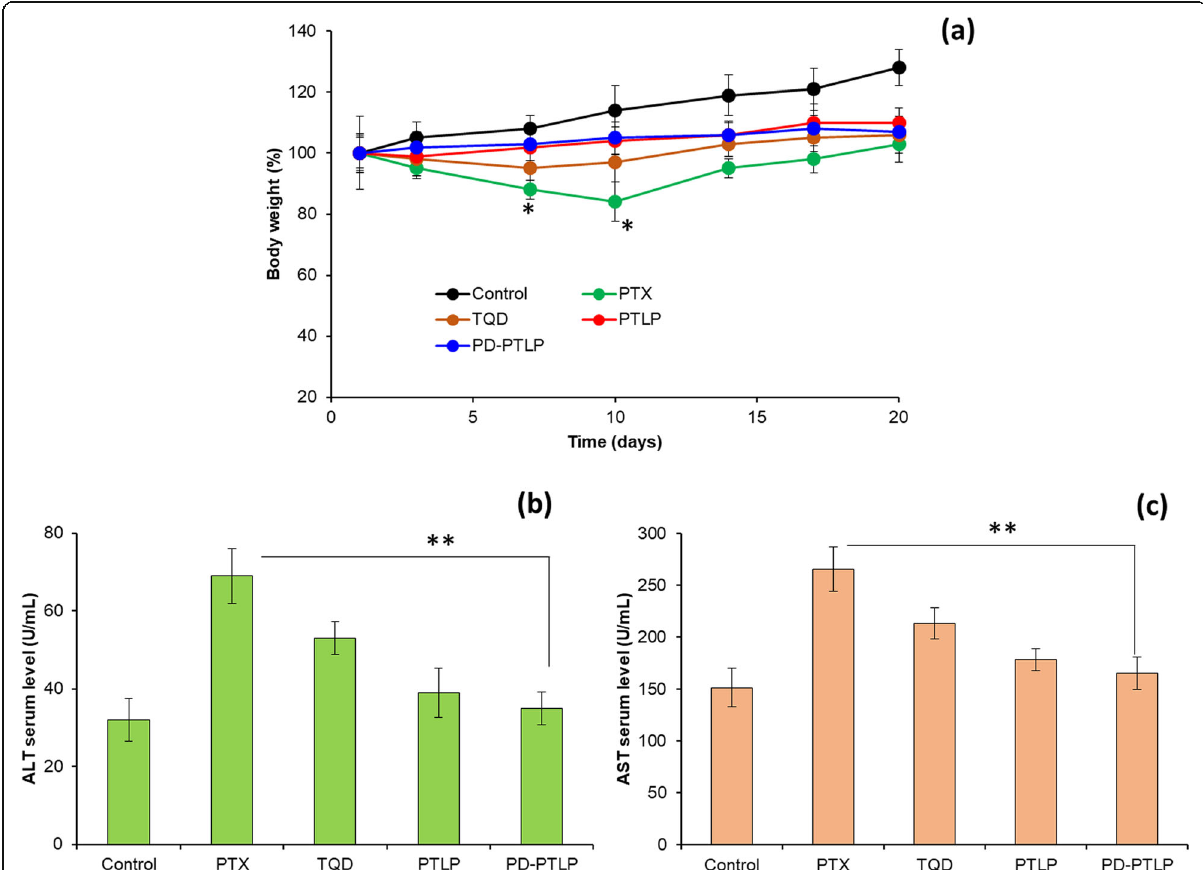
Fig. 7 Systemic toxicity analysis of individual formulations in SGC7901/ADR tumors; a mice body weight analysis; b , c blood biochemical evaluation of serum levels of AST and ALT as a systemic toxicity parameters. * p < 0.05 and ** p < 0.01 is the statistical difference between free PTX and PD-PTLP treated